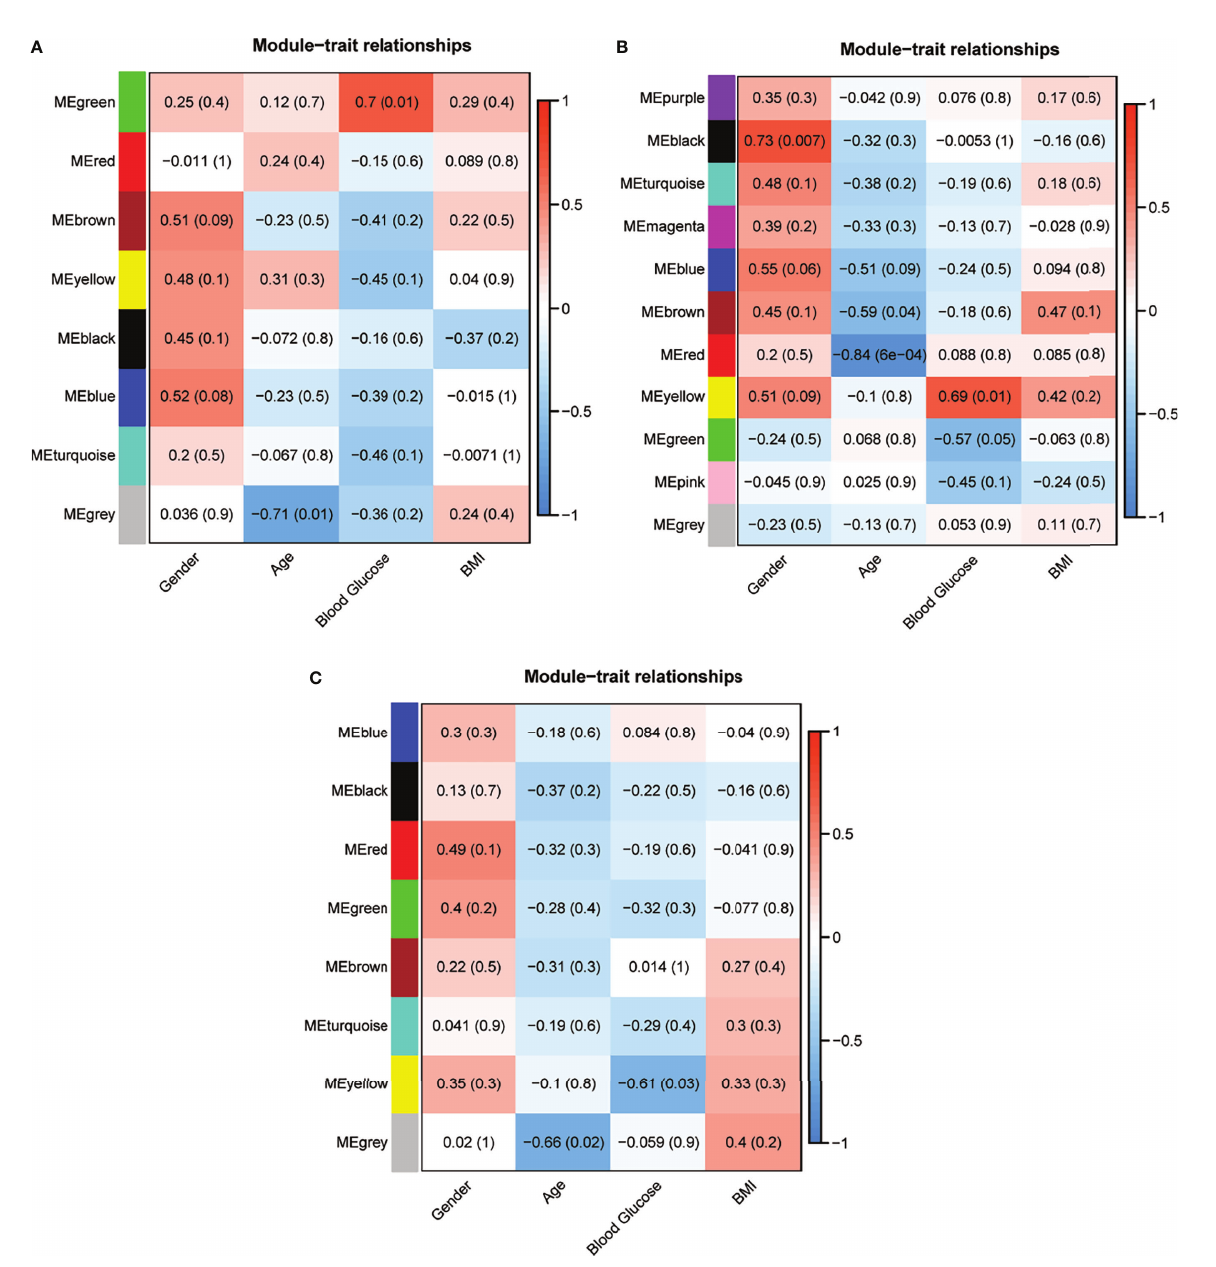
FIGURE 3 | Correlation analysis of the modules and clinical traits in (A) T2DM versus normal controls, (B) T2DM versus prediabetes and (C) prediabetes versus normal controls (Each cell contained the corresponding correlation and P